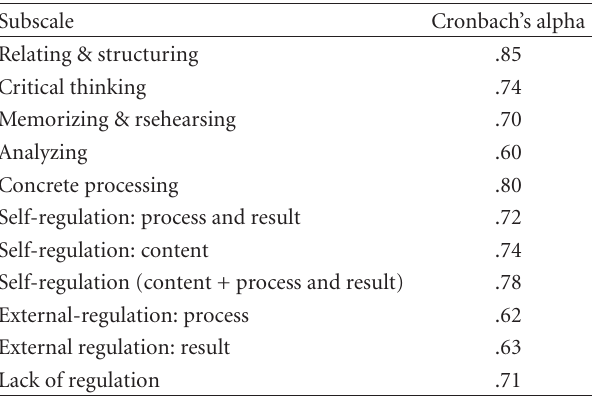
Table 3: Reliability processing and regulation